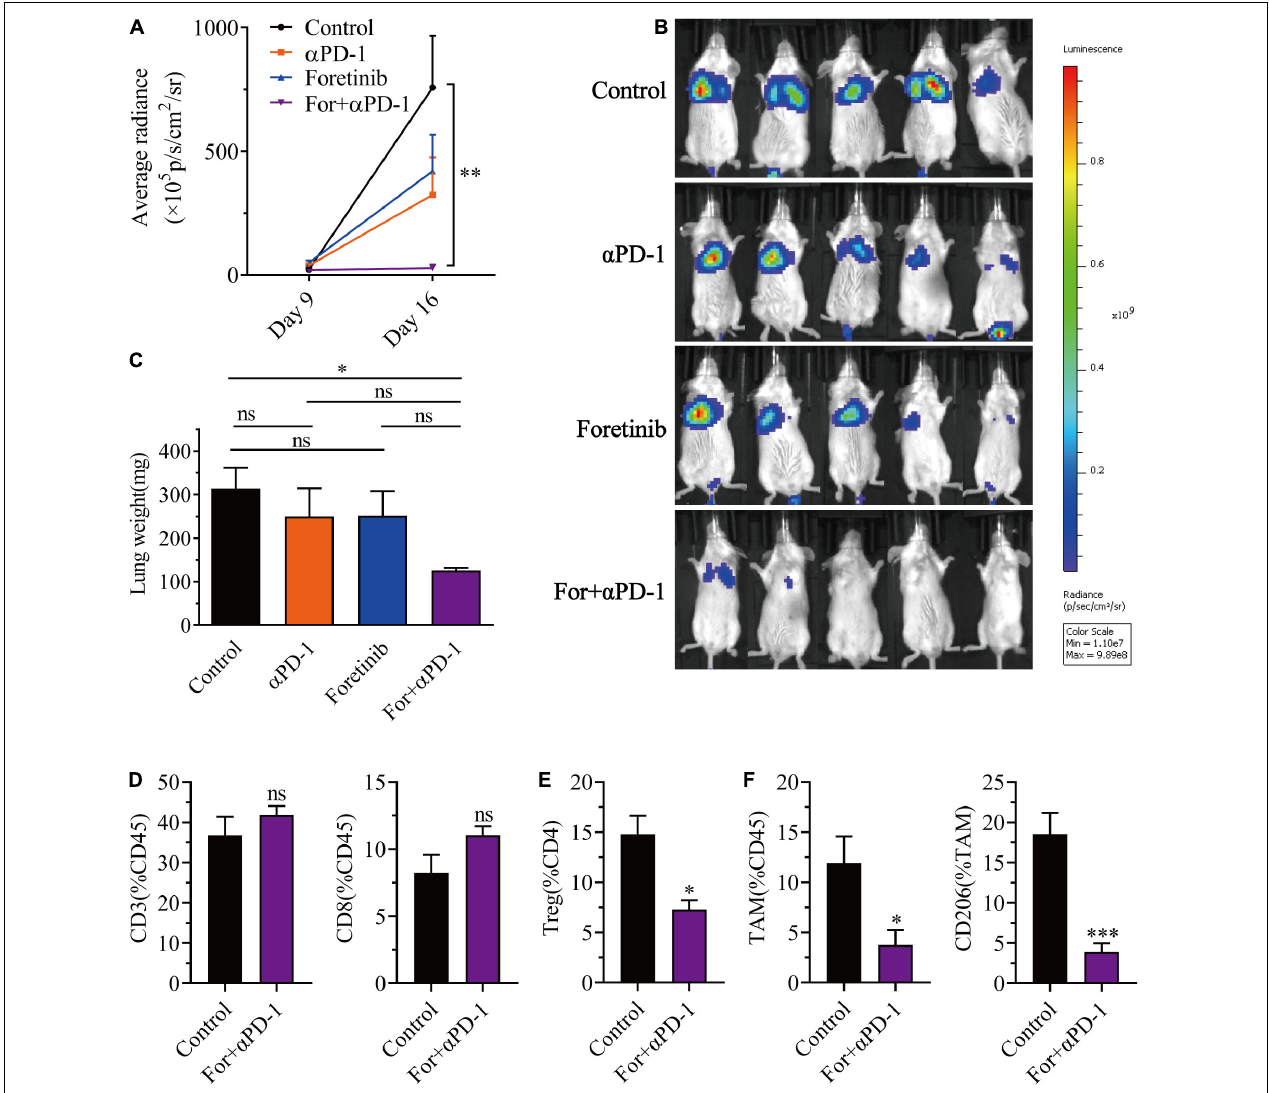
FIGURE 6 | Combination therapy inhibited CT26-Luc tumor metastasis to the lung. CT26-Luc cells (2 × 10 5 ) were intravenous injected into the BALB/c mice. On the third day after transplantation, the mice were randomly allocated to either the control or treatment groups. Drugs were given as described in “Materials and Methods” section. (A,B) The individual tumor load was evaluated via bioluminescence nine and 16 days after inoculation [ (A) , the changes of bioluminescence in each group; (B) , bioluminescence images on day 16] ( n = 5). (C–F) After treatment, the lungs from the mice in each group were weighed (C) and the CD3 + , CD8 + , and CD4 + T cells (D) , Tregs (E) , TAMs were detected, plus the expression of CD206 in the TAMs (F) were identified using FCM ( n = 5). The data is presented using the mean ± SEM where applicable, * ( P ≤ 0.05), ** ( P ≤ 0.01), *** ( P < 0.001), **** ( P < 0.0001), and ns (no statistical significance, P ≥